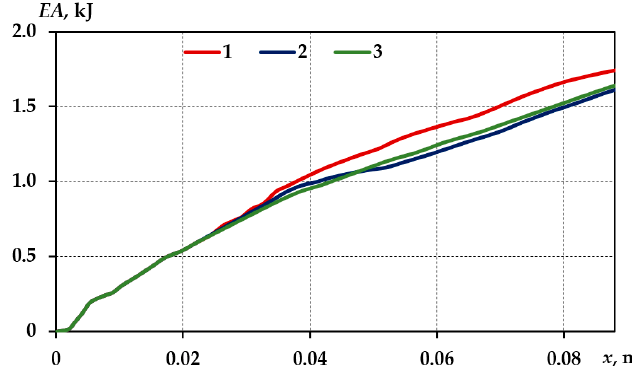
Figure 22. Absorbed energy–axial displacement diagrams of different types of section T1 specimens; (1—original characteristics of all spot-welded joints; 2—manual welding in the 2nd, 3rd and 4th positions; 3—no joints in 3rd–5th and 6th positions).